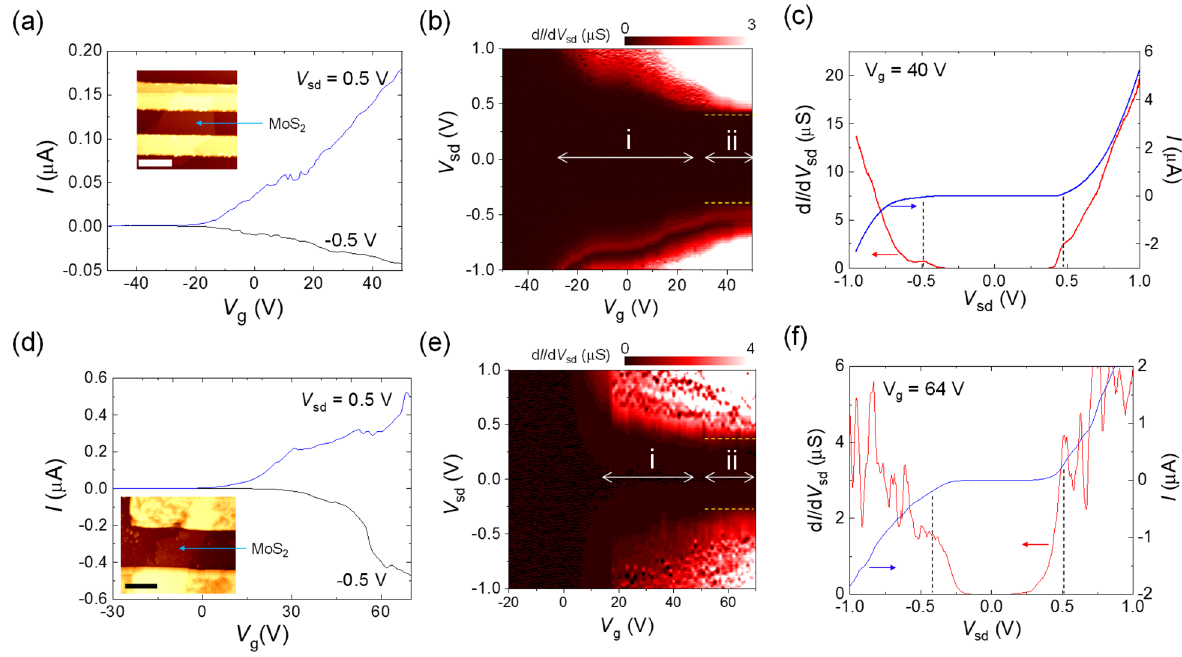
Figure 5. vdW gap tunneling spectroscopy for 2 H -MoS 2 . ( a ), ( d ) Current vs. back-gate voltage ( I – V g ) curves at V sd = ± 0.5 V and T = 4 K for MS1 and MS2, respectively. Insets of ( a ), ( d ): AFM images of MS1 (scale bar: 1 μm) and MS2 (scale bar: 2 μm), respectively. The thickness of the MoS 2 flakes in both cases was ~10 nm, corresponding to ~ 14 MoS 2 layers. ( b ), ( e ) Differential conductance (d I /d V sd ) as a function of V sd and V g of MS1 and MS2, respectively. The zero-conductance region on the V sd axis became smaller with increasing V g in region “i” and did not change in region “ii”. The two dashed lines indicate the edges of the bandgap. ( c ), ( f ) d I /d V sd and I as a function of V sd at V g = 40 and 64 V for MS1 and MS2, respectively. The left and right vertical dashed lines located at the conductance shoulders correspond to the edges of the conduction and valence bands, respectively.